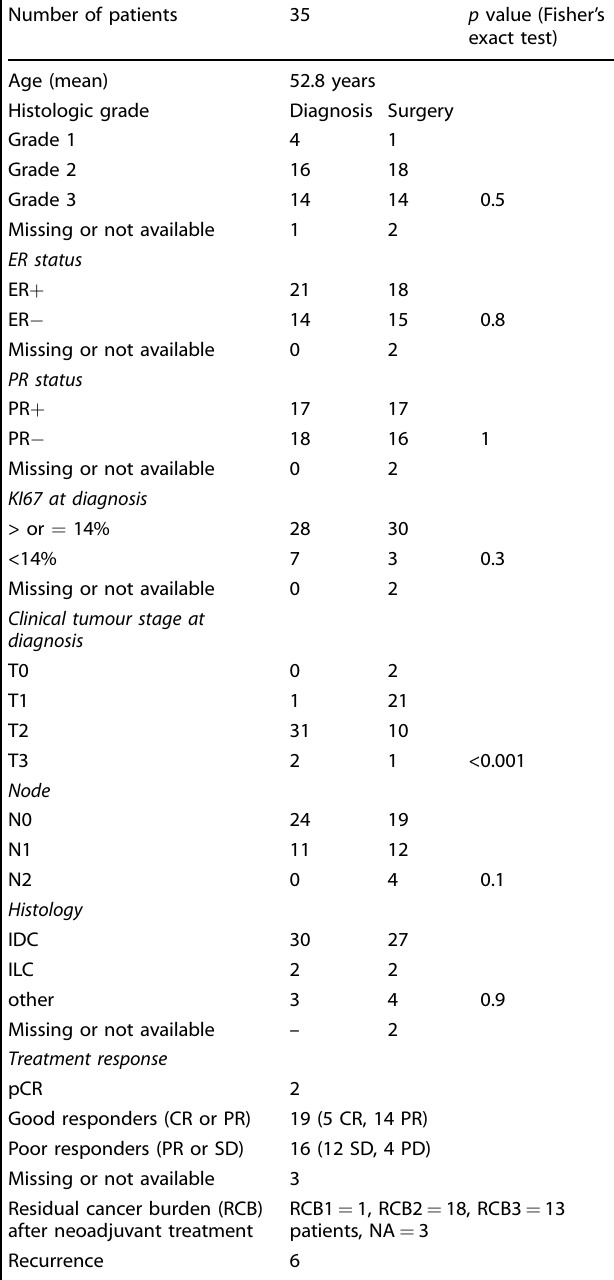
Table 1. Clinicopathological characteristics of the study